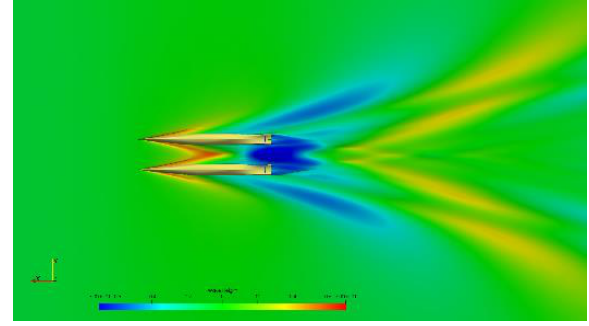
Figure 4. Wave Pattern of the Stavanger demonstrator at 23 kts.